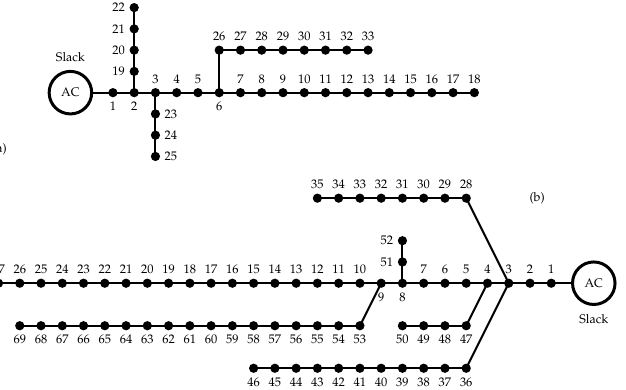
Figure 2. Electrical diagram of ( a ) the 33-bus test system and ( b ) the 69-bus test system [12].